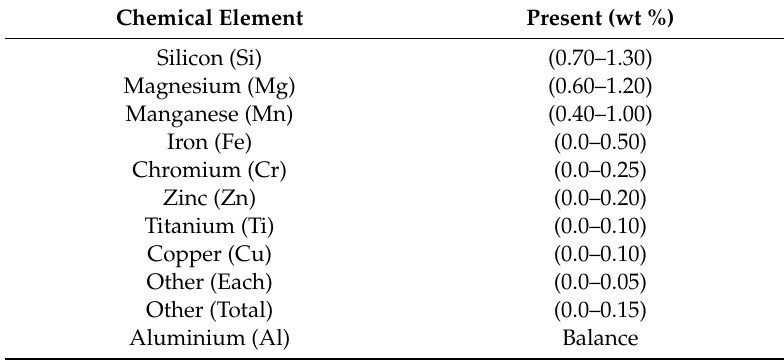
Table 1. Element composition of the AA6082-T6 aluminium alloy (wt %)